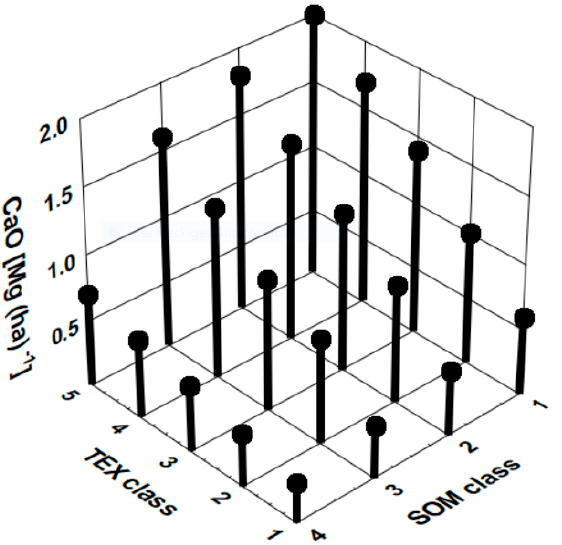
Figure 3. CaO amounts to maintain the optimum pH range (lime supply status C) depending on the soil texture classes and soil organic matter classes. These VDLUFA recommendations refer to a crop rotation of 4 years.